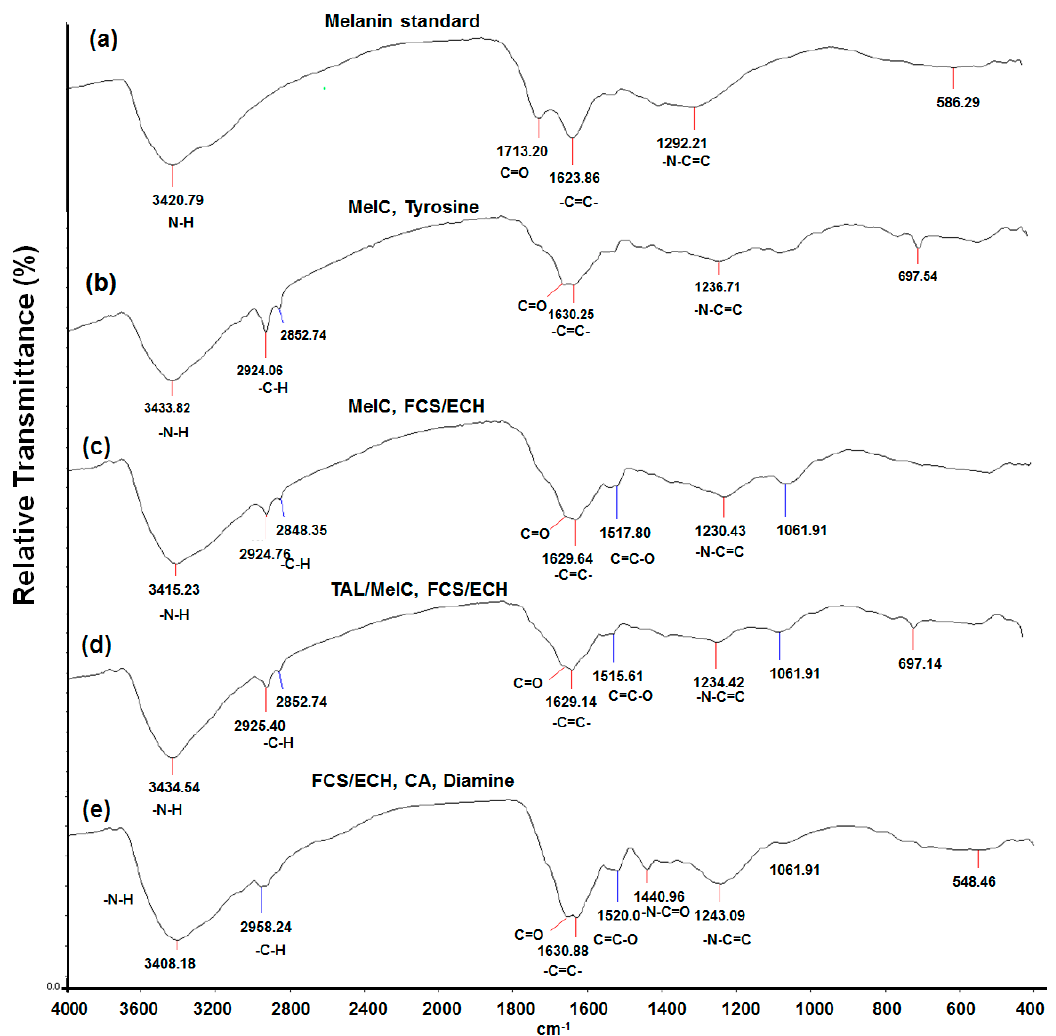
Figure 6. IR spectra of (a) commercial melanin as a control, (b) MelC, tyrosine, (c) MelC, FCS/ECH, and tyrosine, (d) TAL/MelC, FCS/ECH, and (e) FCS/ECH, caffeic acid, and diamine.